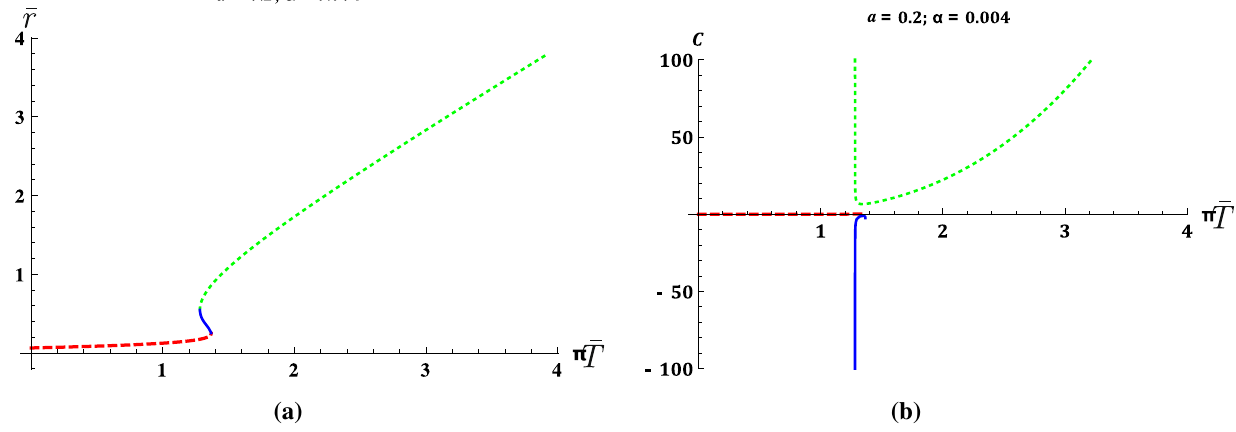
Fig. 5 a ¯ r vs π ¯ T plot b ¯ C vs. π ¯ T with ¯ α = 0 . 004, ¯ a = 0 . 2 for black holes with horizon radii small (red), medium (blue) and